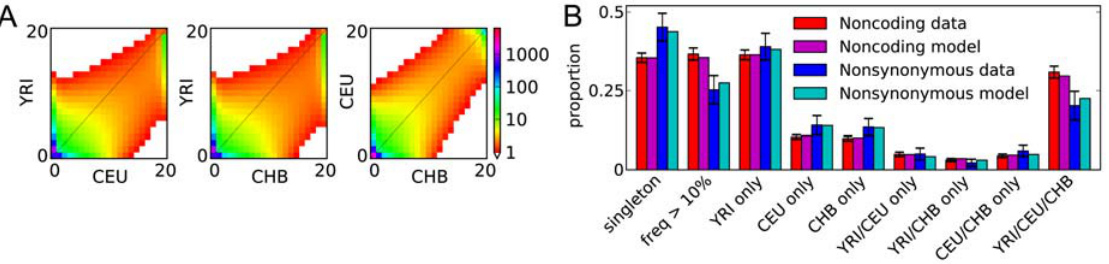
Figure 4. Distribution of nonsynonymous polymorphism. We simulated our maximum-likelihood Out of Africa demographic model with a distribution of selective effects previously inferred for nonsynonymous polymorphism [49]. (A) To enable direct comparison with the neutral AFS (Figure 2C), the scaled mutation rate h was set identically, as is the color scale. As expected, selection dramatically reduces the amount of segregating polymorphism. (B) Shown are the proportions of variation found in various frequency classes. As expected, nonsynonymous variants typically have lower frequency. They also less likely to be shared between populations. Data error bars indicate 95% bootstrap confidence intervals.